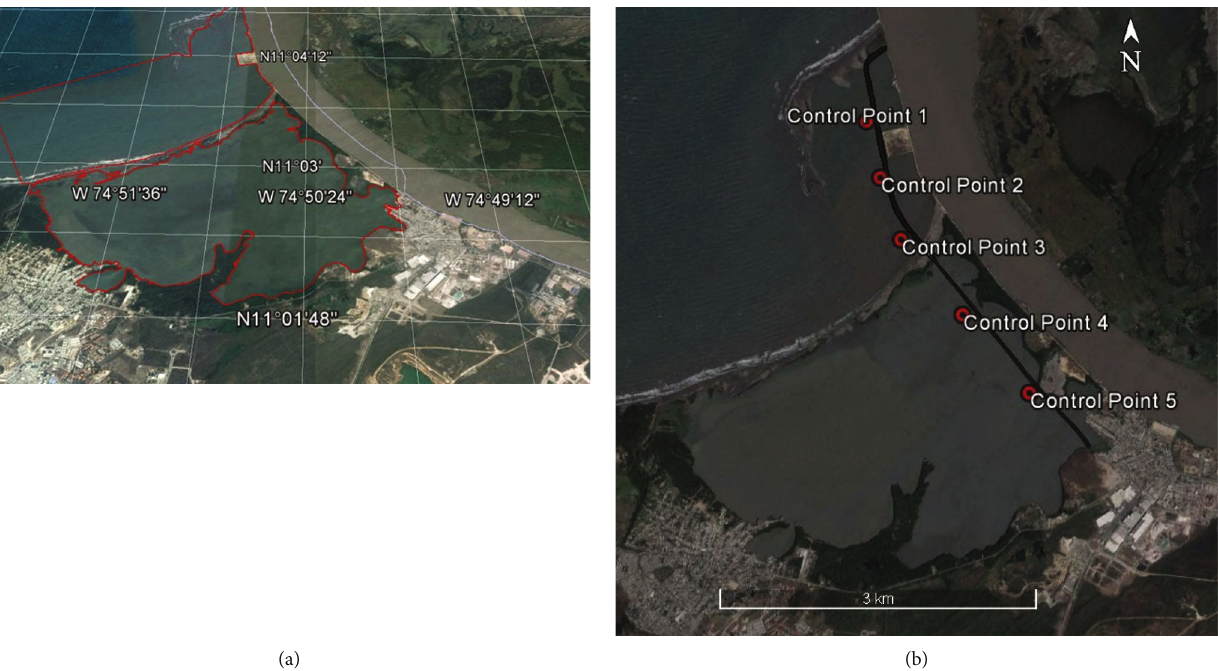
Figure 4: Coastal lagoon location: (a) Numerical domain coastal lagoon. (b) Roadway project and control points measurement.